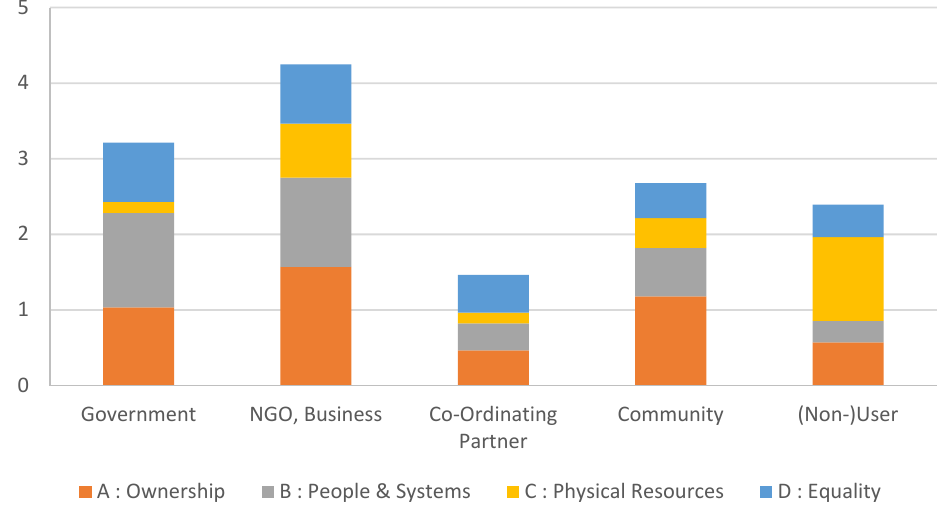
Figure 3. Total Factor/Level Breakdown.